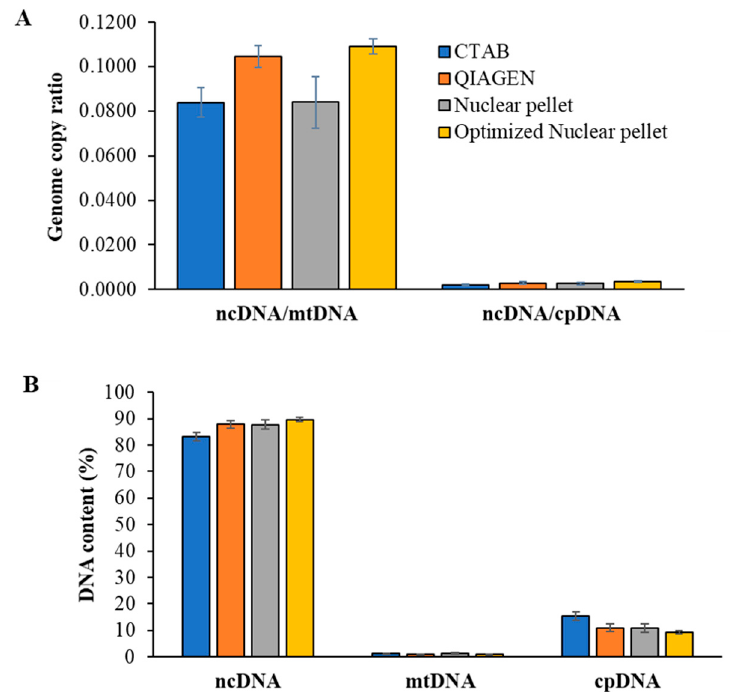
Figure 3. Comparison of genome relative abundance using qPCR. Genomic DNA from young leaves of rice ( Oryza sativa L.) plant was extracted by the traditional CTAB-based (CTAB), QIAGEN DNeasy Plant Mini Kit (QIAGEN), NP, and optimized NP methods. Genome copy ratio ( A ) and DNA contents ( B ) were assessed according to Takamatsu et al. [18]. ncDNA, mtDNA, and cpDNA represent nuclear DNA, mitochondrial DNA, and chloroplast DNA, respectively. Data are presented as mean ± SD of three independent biological replicates from each extraction method.